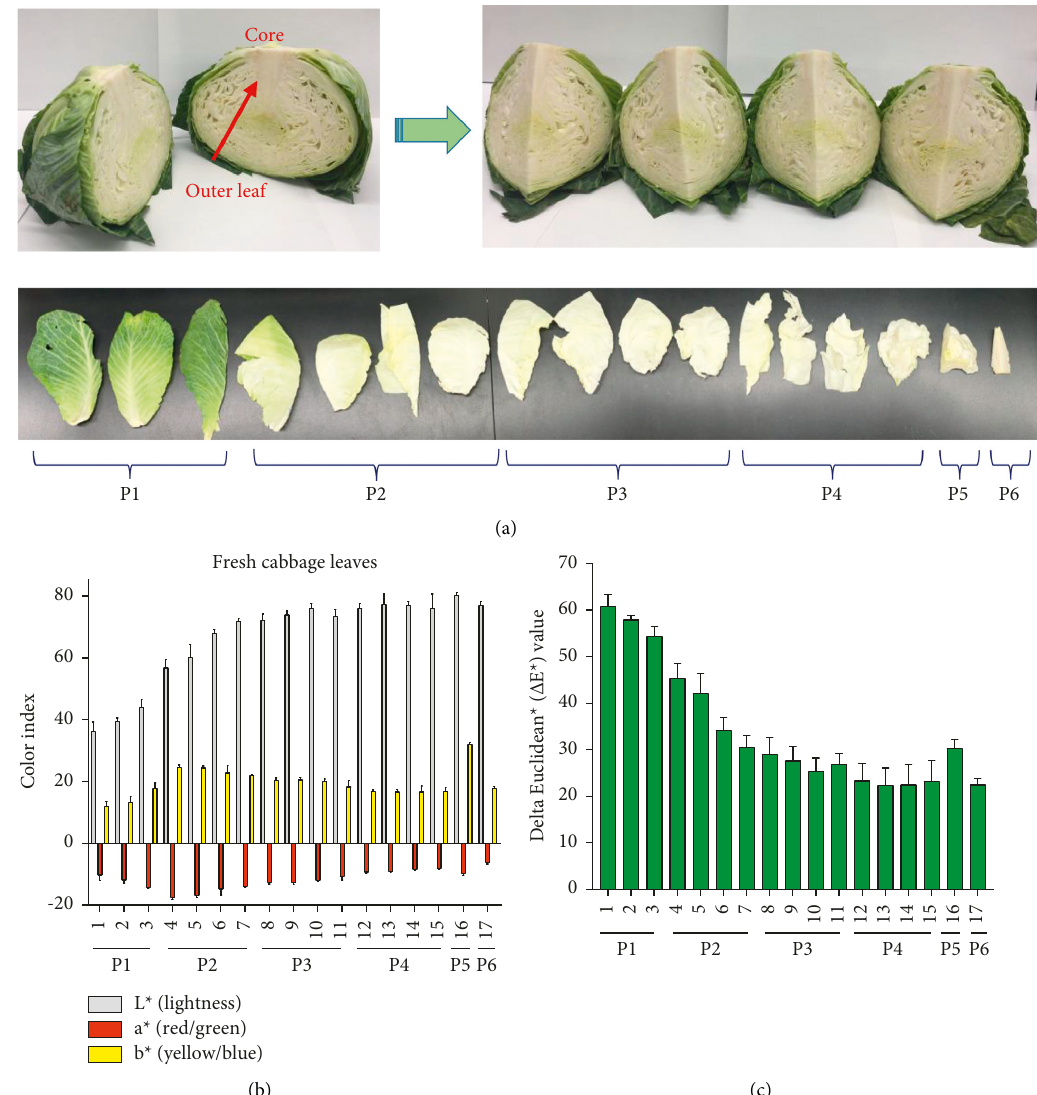
Figure 1: Separation of different cabbage leaf layers and analysis of color index. (a) After cutting into quarters, the leaf layer was peeled off from the outer leaf, and all leaf layers were divided into 6 parts (P1–P6). P1 is the outer layer, and P6 is the core part. (b and c) Color index and total color difference between the different parts of cabbage leaves ( Δ E ∗ ). L ∗ , lightness; a ∗ , red/green coordinate; b ∗ , yellow/blue coordinate; Δ E ∗ , total color difference. The mean and standard deviation were calculated following three independent